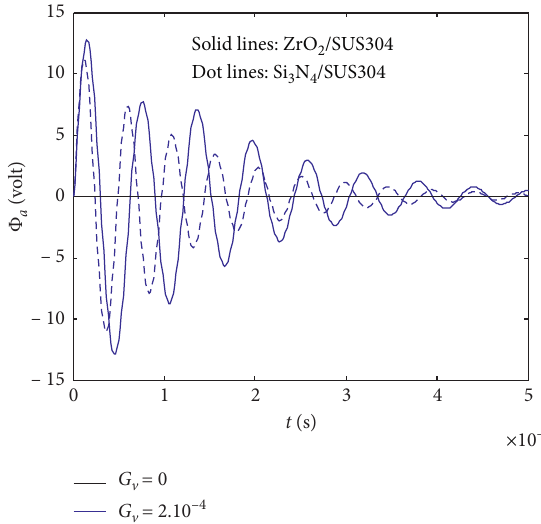
Figure 9: The dependence of ϕ T � 300K, SSSS. � 1,